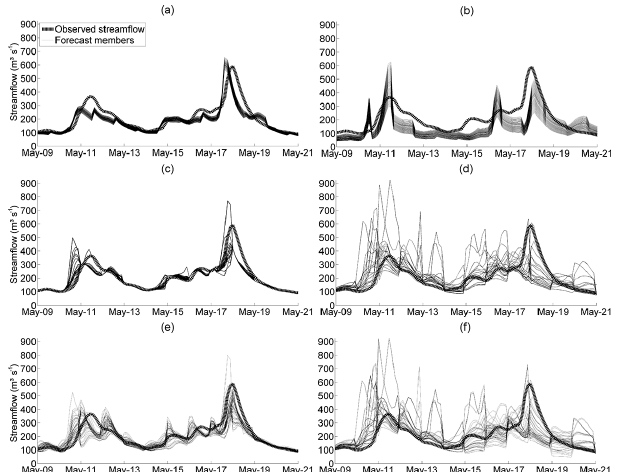
Figure 4. A portion of the 1-day (left) and 5-day (right) forecasted 3h time step hydrograph in 2014 against the observed streamflow; (a) and (b) are dressed forecasts, (c) and (d) are forecasts based on meteorological ensembles without EnKF and (e) and (f) are fore- casts based on meteorological ensembles with state variable uncer- tainty estimated using the EnKF.